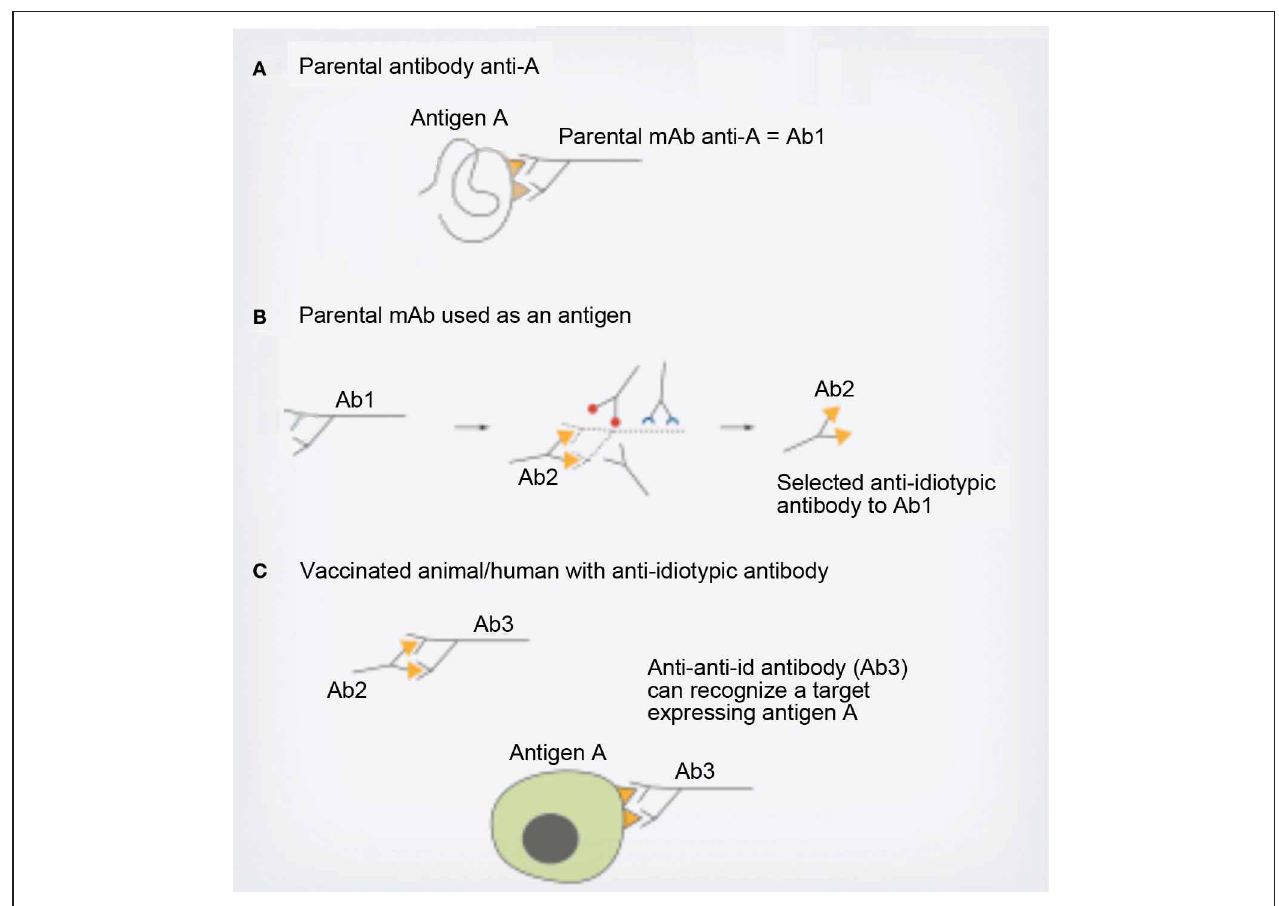
anti-anti-Id + /anti-antigen + ). Immunizing an animal with antigen A (A) raises Ab1. Animals immunized with Ab1 will mount a polyclonal antibody response, amongst which Ab2 may be selected as an anti-idiotypic antibody (B) . Patients or animals vaccinated with Ab2 may mount an Ab3 antibody response, which may both recognize and kill tumor cells expressing the antigen A (C) . mAb, Monoclonal